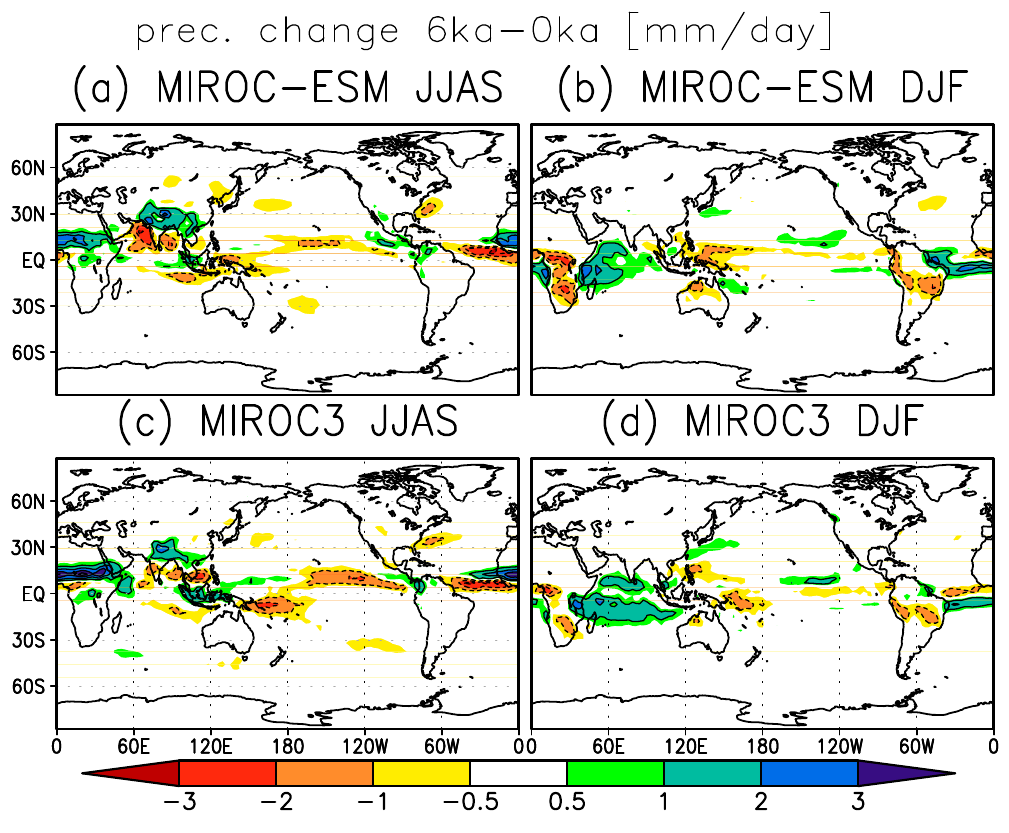
Fig. 5. The same as Fig. 3 but for precipitation changes [mmday − 1